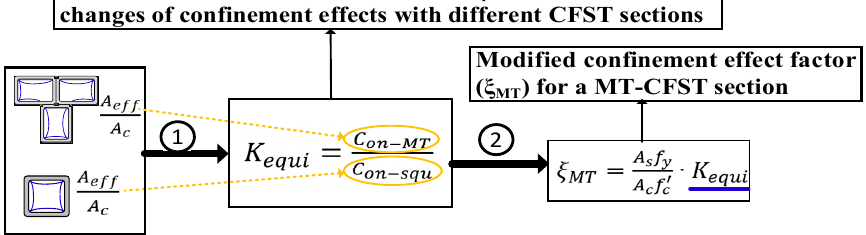
Figure 2. Illustration of the development of the modified confinement factor ( ξ MT ).